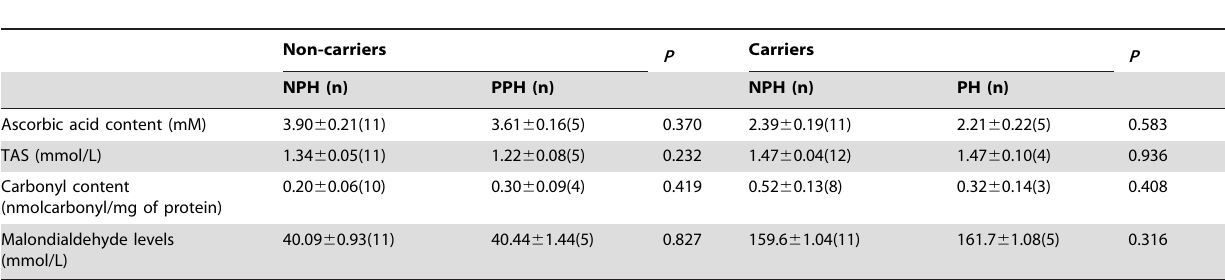
Table 3. Ascorbic acid content, total antioxidant status, carbonyl content and malondialdehyde levels in TP53 p.R337H mutation carriers and non-carriers with positive (PPH) and negative (NPH) personal histories of